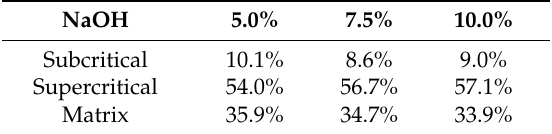
Table 6. Percentage contribution of the phases to the tensile strength of the composite.